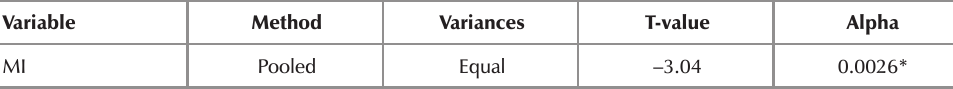
T-test procedure on the relationship between written ethical standards and unethical behaviour Variable Method